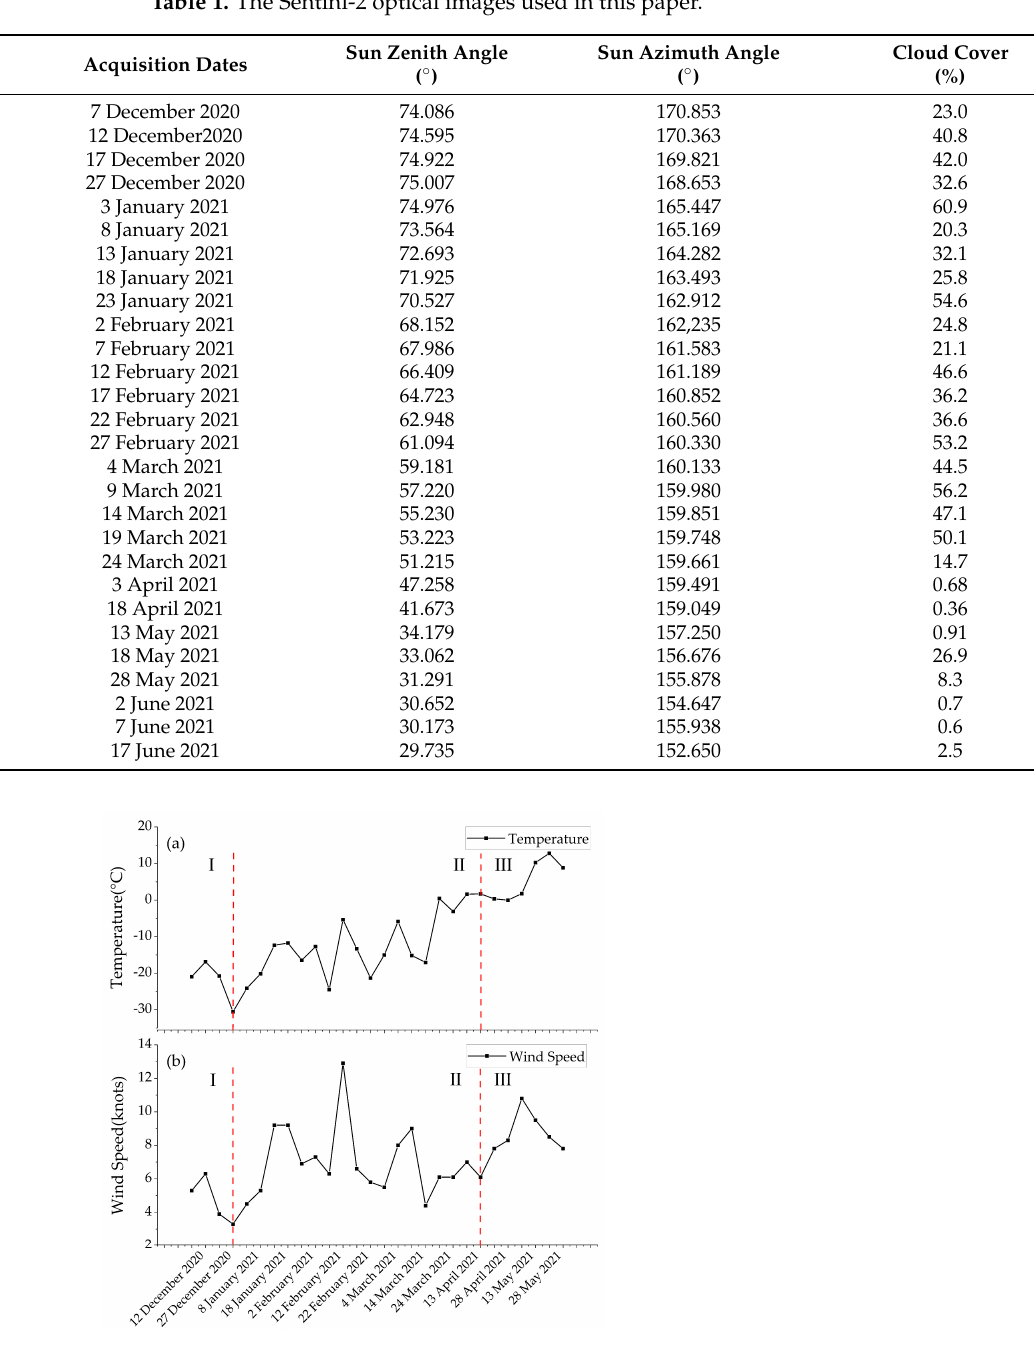
Figure 3. Weather data collected from NOAA’s stations for Lake Khovsgol from 1980–2020. Table 1. The Sentinl-2 optical images used in this paper. Sensor